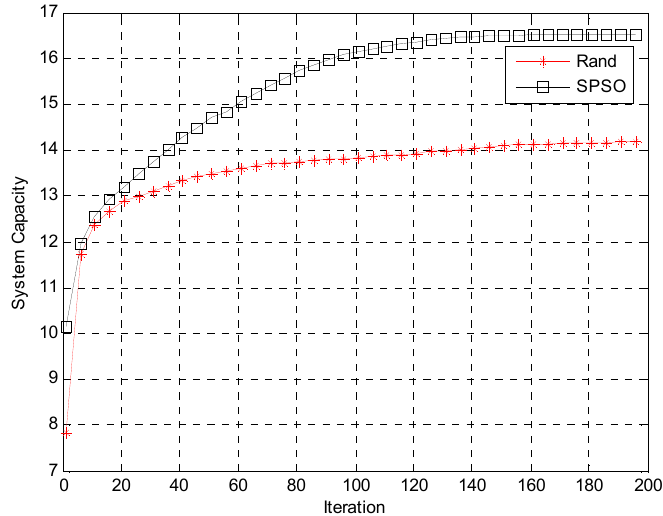
Figure 4. Simulation results comparisons between SPSO and random allocation method with M = 10 and K = 18.